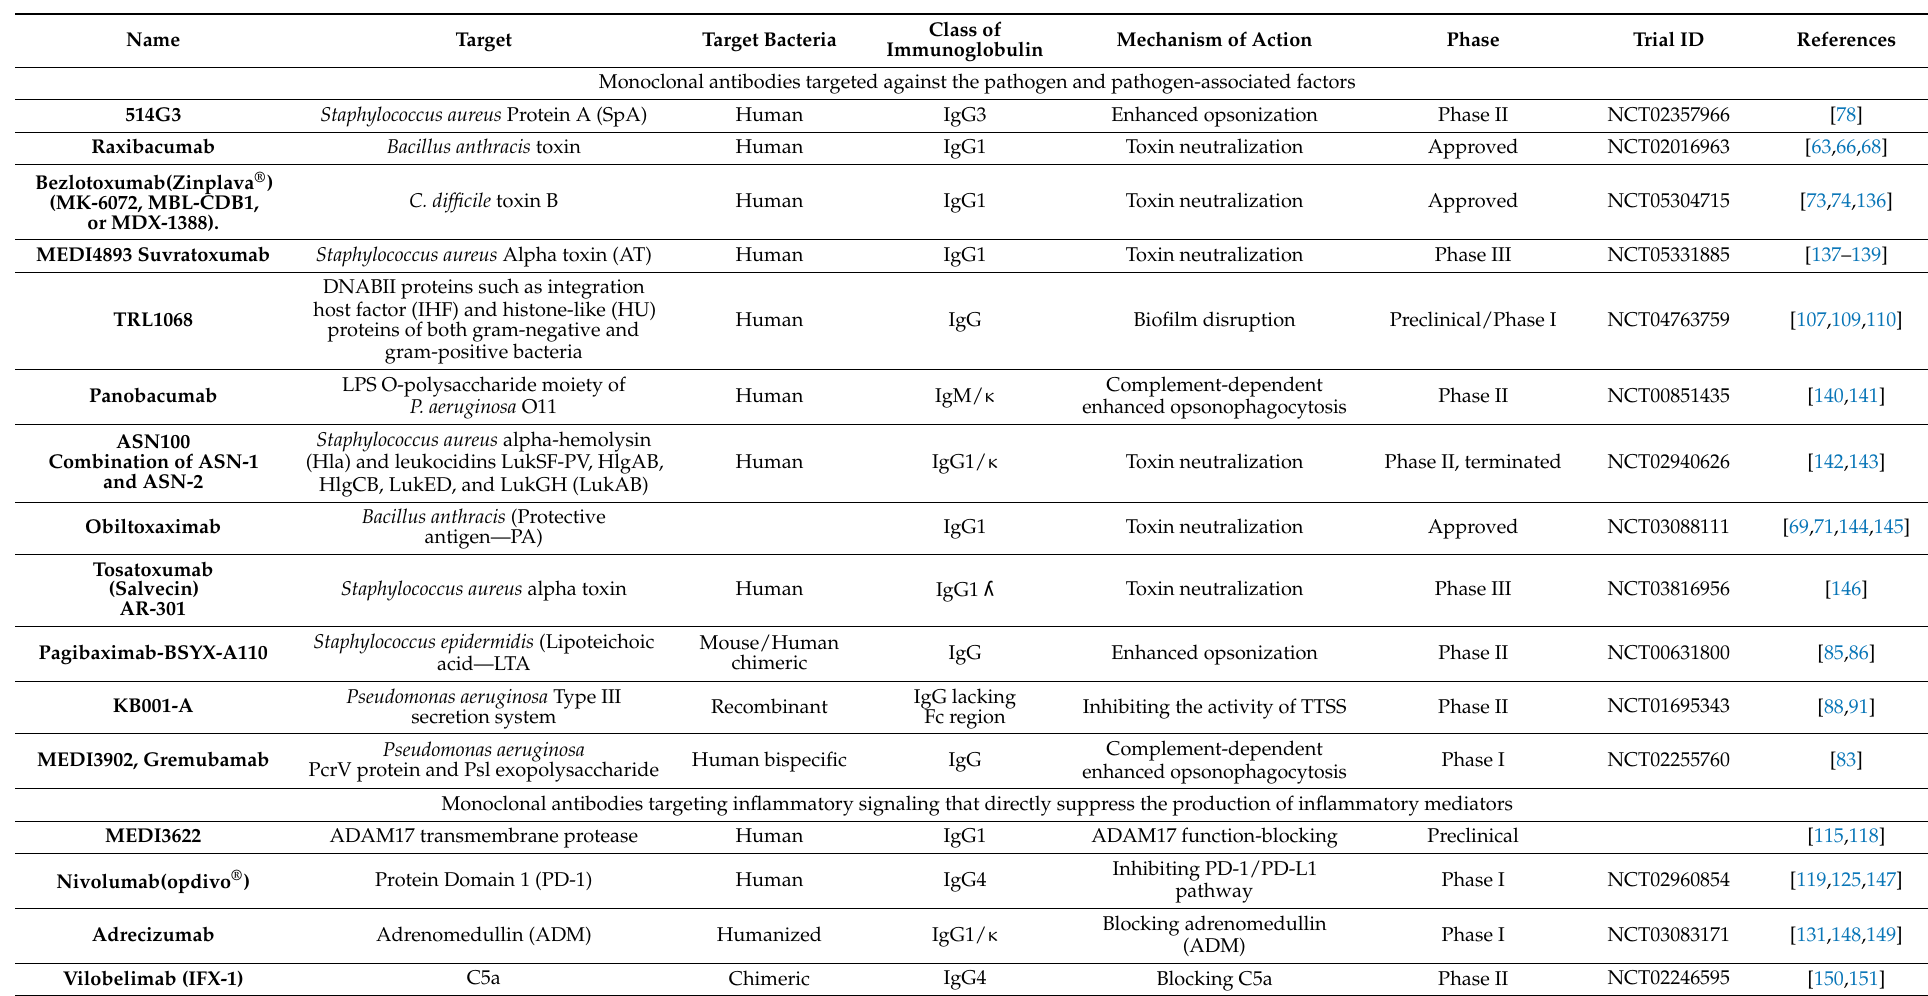
Table 1. Monoclonal-antibody-based biologics that are FDA approved or in clinical trials for the treatment of